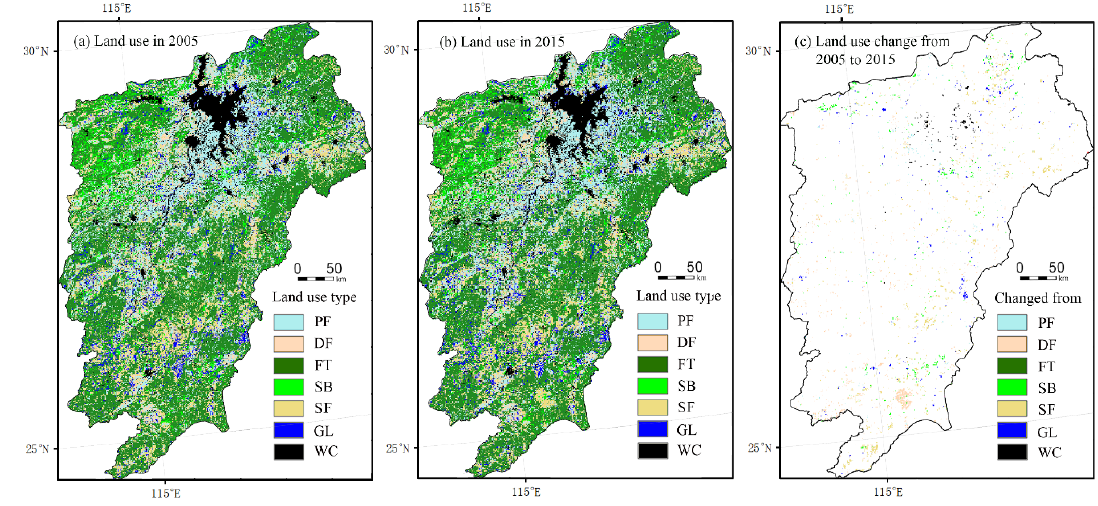
Table 1. Transfer matrix of land-use change from 2005 to 2015 (unit: km 2 ).